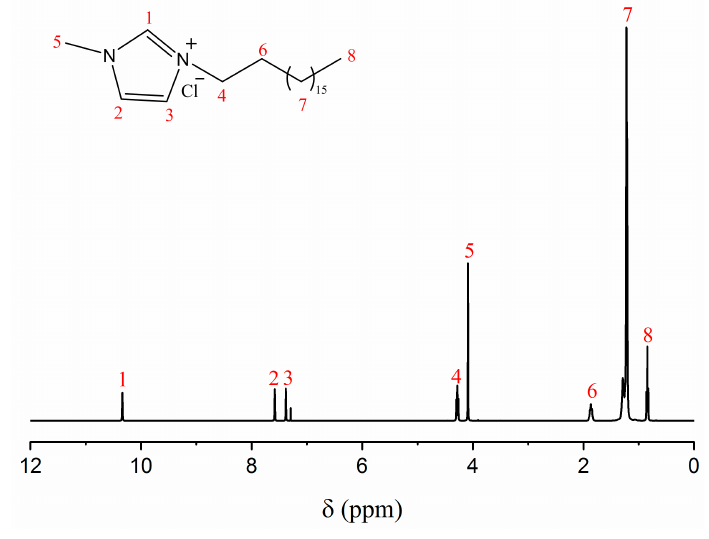
Figure 1. 1 H NMR spectrum of C 18 MIMCl in CDCl 3 .